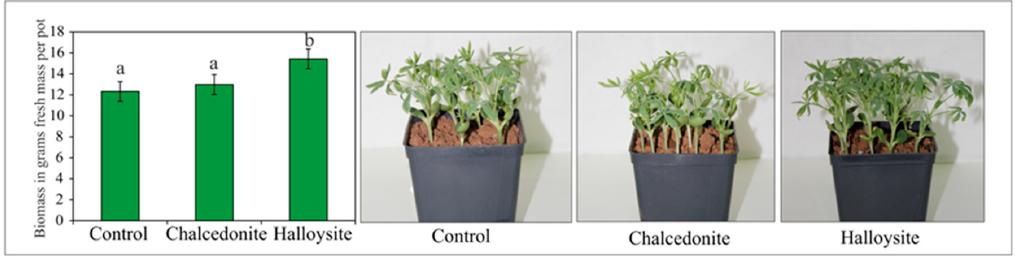
Figure 4. The effect of mineral ‐ based amendments on the yield of above ‐ ground biomass of L. luteus . Error bars ± standard error ( n = 3). Different letters denote significant differences between treatments.